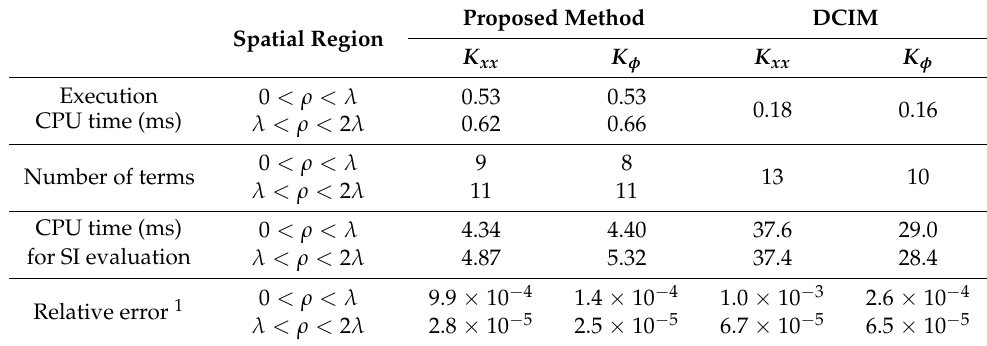
Table 1. Performance comparison for different SI approximation methods for a microstrip structure.